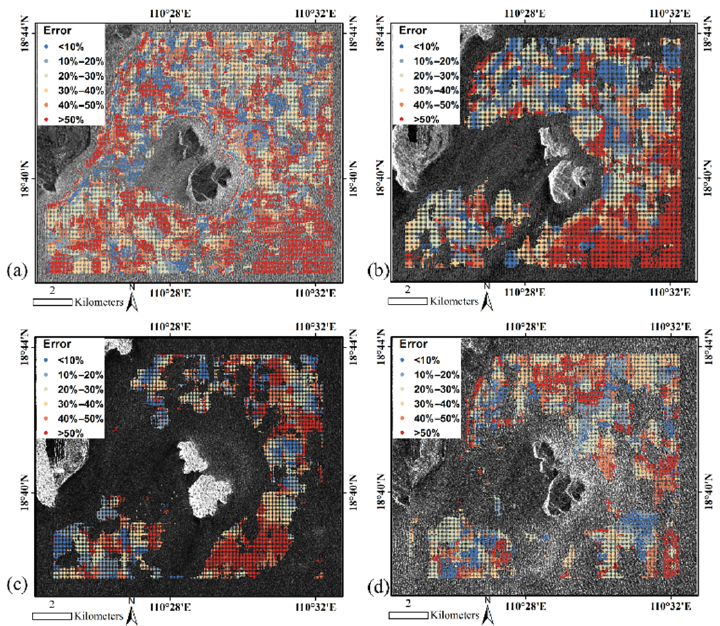
Figure 7. Error of retrieval depths, GF-3, Sentinel-1, ALOS PALSAR, and ENVISAT ASAR were shown in the ( a – d ). The blue dots indicated that the MRE was less than 10%, and the red dots indicated that the MRE was greater than 50%.